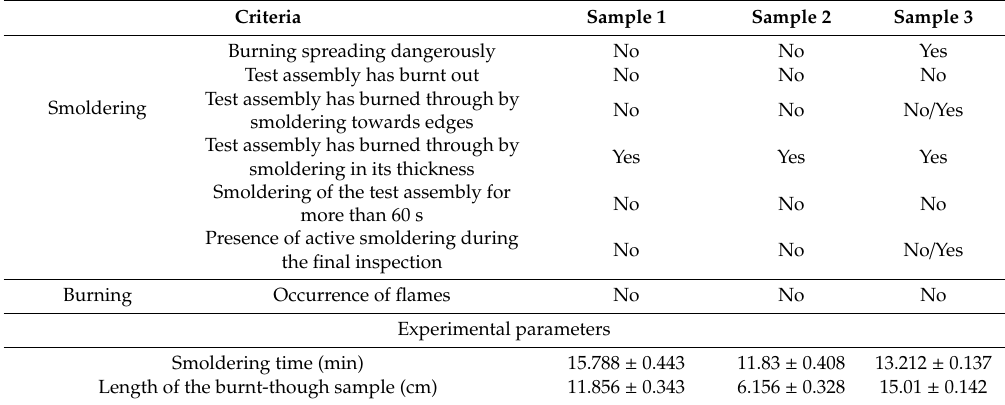
Table 3. Evaluation tests with a smoldering cigarette according to the given criteria [8]. Criteria Sample 1 Sample 2 Sample 3